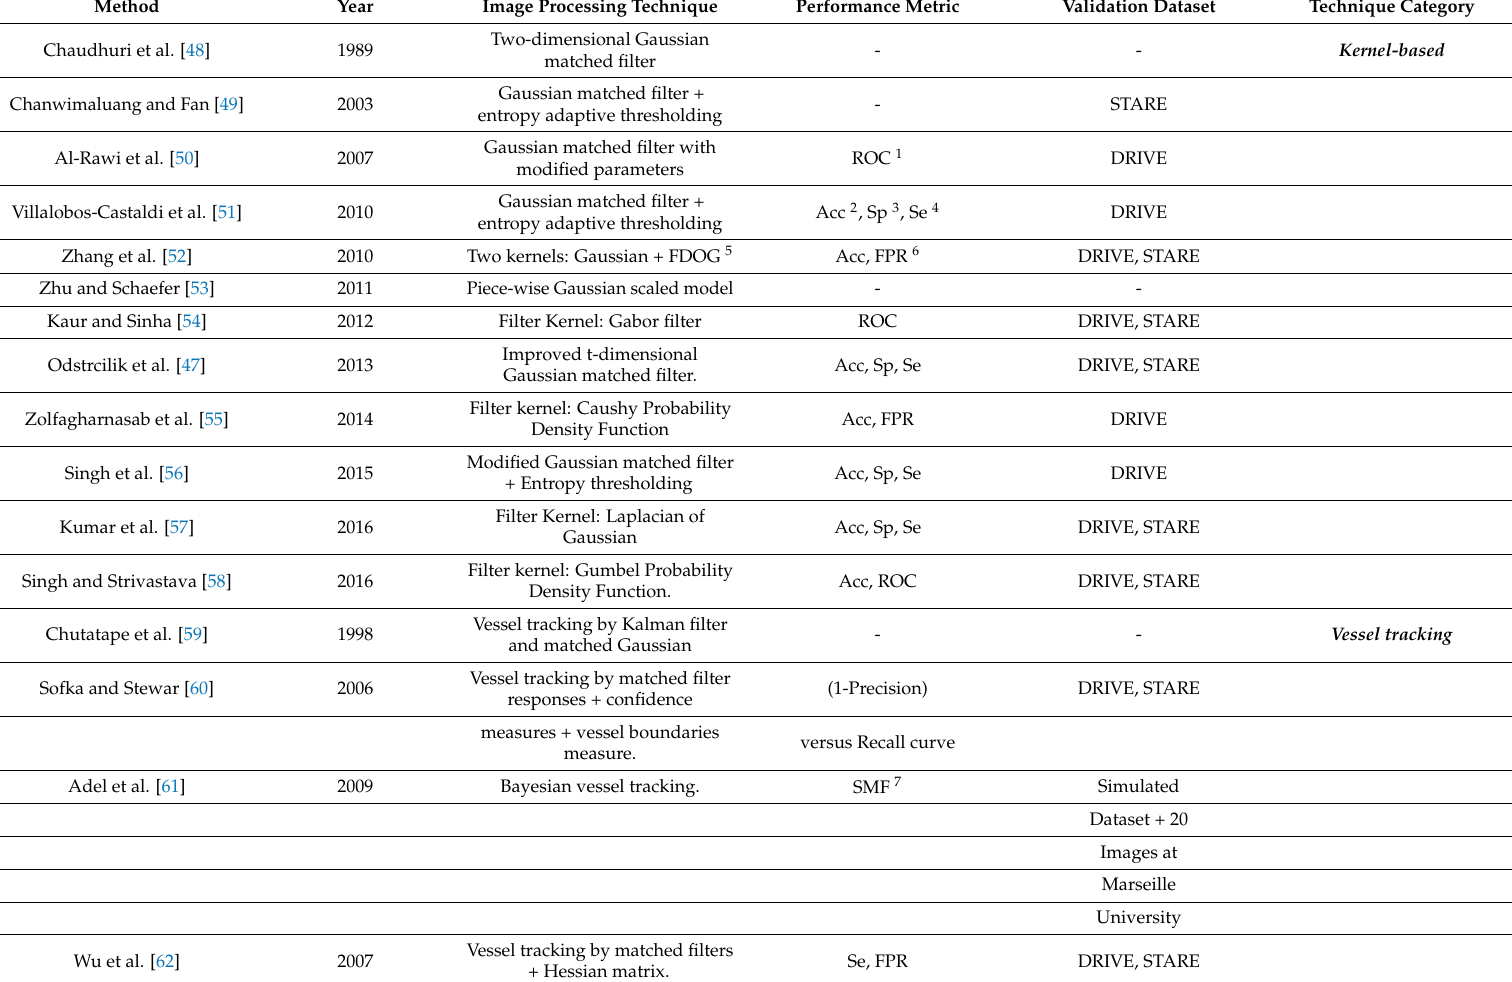
Table 1. Categorization of retinal vessel segmentation